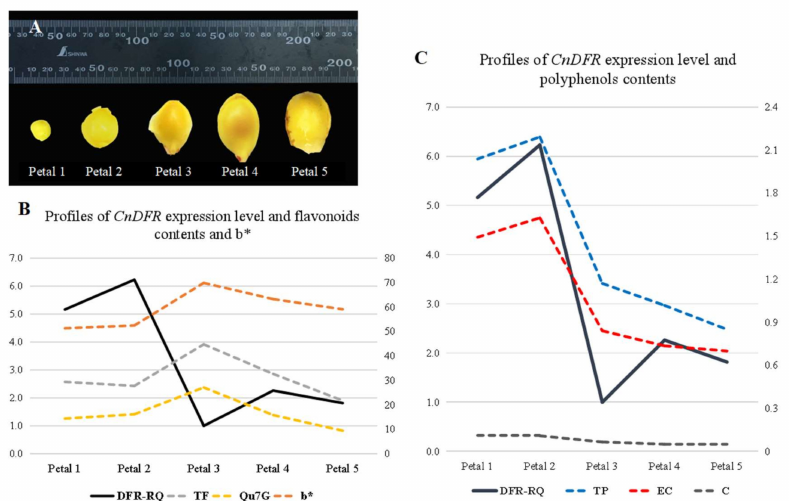
Figure 3. The relationship between DFR relative expression level and the chemical components content in petals of C. nitidissima Chi. ( A ) Petals in 5 stages of C. nitidissima Chi.: petals of young bud, petals of big bud, petals of half-open flower, petals of blooming flower, petals of withered flower. ( B ) CnDFR relative expression level and flavonoids contents and b* in petals of C. nitidissima Chi. DFR-RQ (the relative expression level of DFR ) in 5 stages had an M-shaped trend. TF (the content of total flavonoids), Qu7 G (quercetin-7-O- β -D- glucopyranoside) and b* (yellow color index of petals) were negatively correlated with the expression level of CnDFR . ( C ) CnDFR expression level and polyphenols components. TP (the content of total polyphenols), EC (the content of epicatechin) and C (the content of catechin) were positively correlated with the expression level of CnDFR